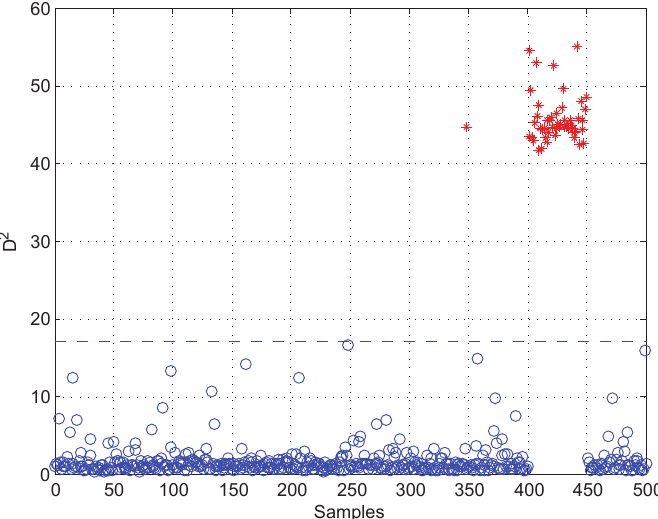
Figure 9. Fault detection result after reconstructing v 1